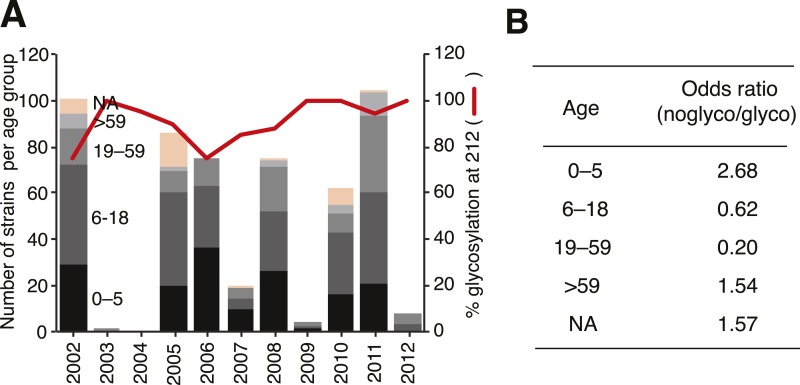
Glycosylation at Asn 212 and correlation with age groups for Victoria
viruses.Yamagata viruses showed five instances of glycosylation loss at 212,
compared to 71 instances in Victoria, hence Victoria lineage strains have
been analyzed in detail here. Temporal distribution of age groups and
glycosylation at 212 for all Victoria strains (A). Summary of
odds ratio (OR) for association of glycosylation loss at 212 with the
different age groups (B). OR values >1 indicate that it
is more likely to find a 212 loss in the respective age group, whereas
values <1 indicate that 212 losses are less likely to be found in the
respective groups. The following guideline helps judging significance of OR:
strong positive association >3; moderate positive association
1.5–3; moderate negative association 0.33–0.66; strong
negative association <0.33.